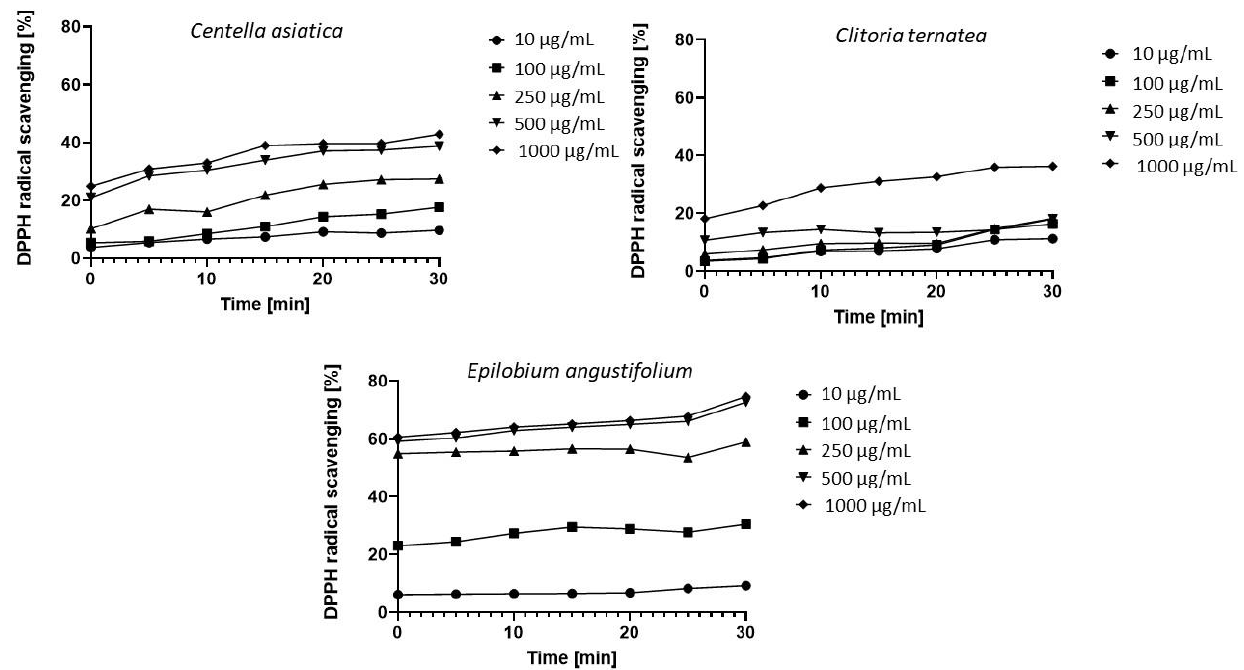
Figure 2. Kinetics of the absorbance changes in DPPH∙solutions in the presence of various concentrations of water-ethanol extract of Centella asiatica L., Clitoria ternatea L., Epilobium angustifolium L. Values are the mean of three replicate determinations (n = 3).